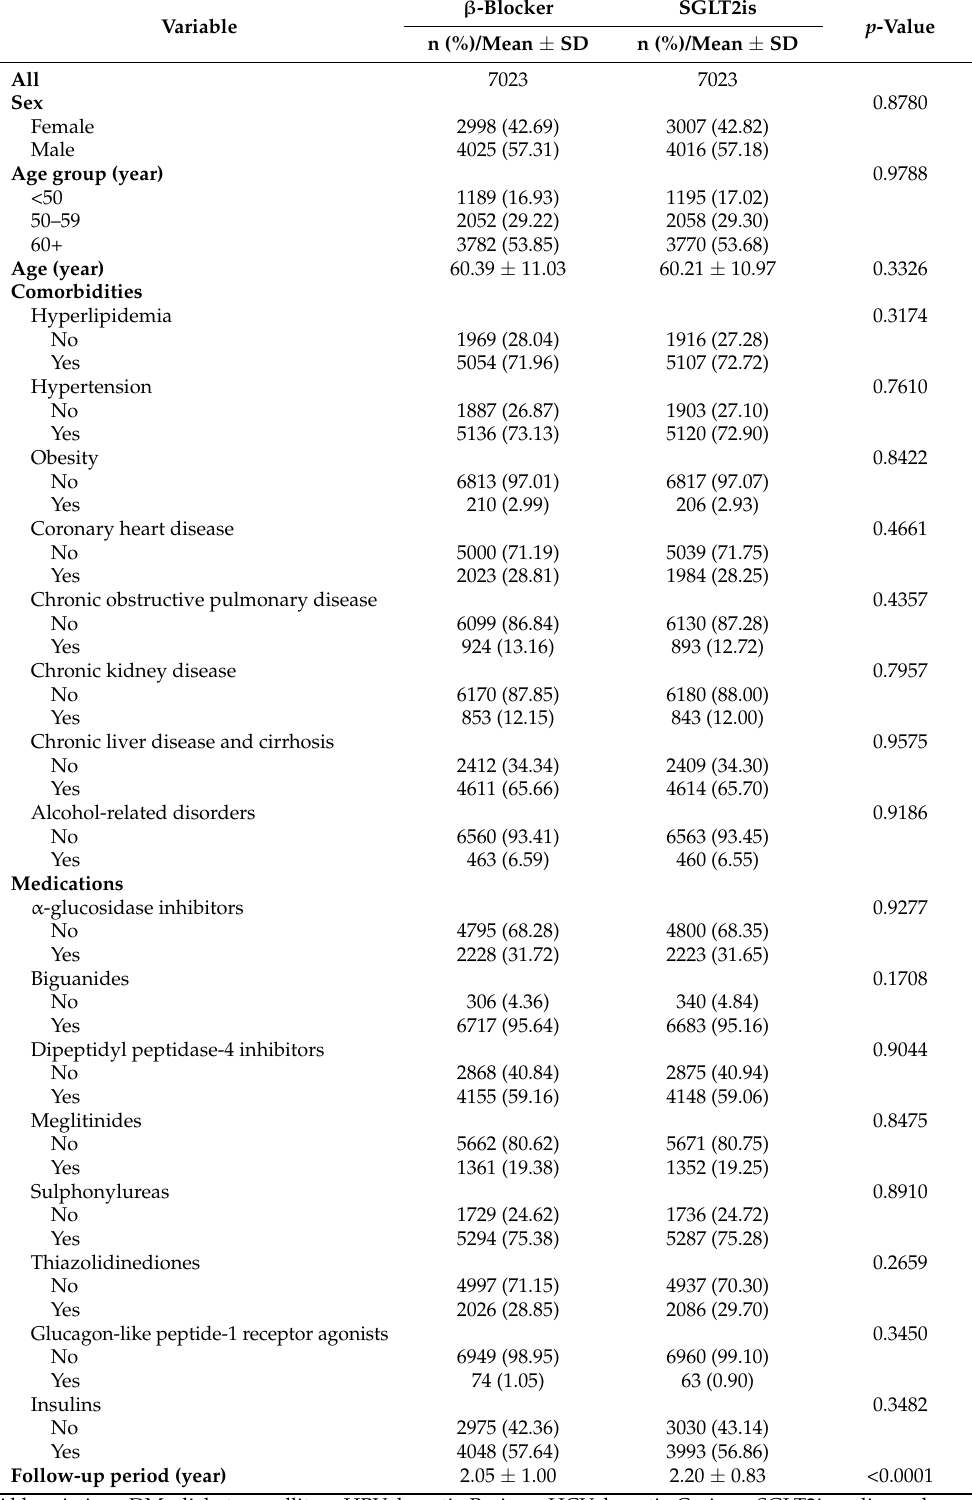
Table 1. Baseline characteristics among DM patients with HBV/HCV receiving β -blockers or